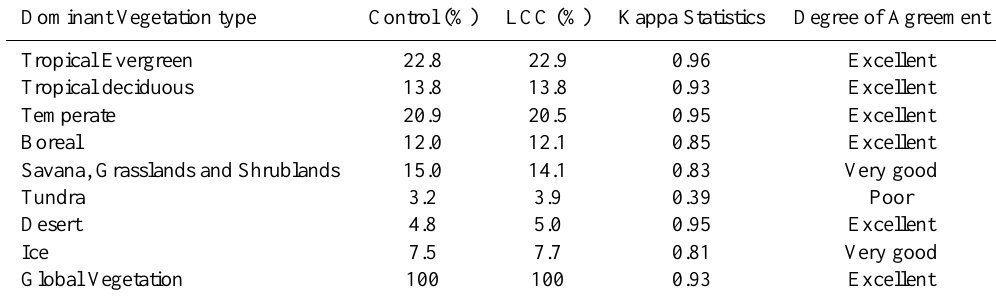
Table 2. Areal extent of dominant vegetation types and Kappa statistics.